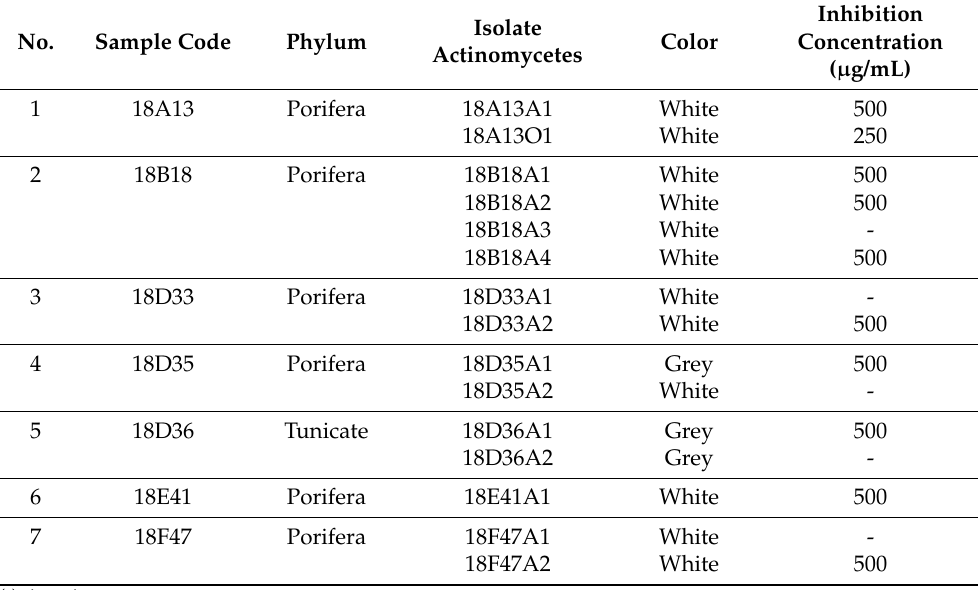
Figure 1. Collection of some marine organisms from Buleleng, Bali. Table 1. Screening actinomycetes EtOAc